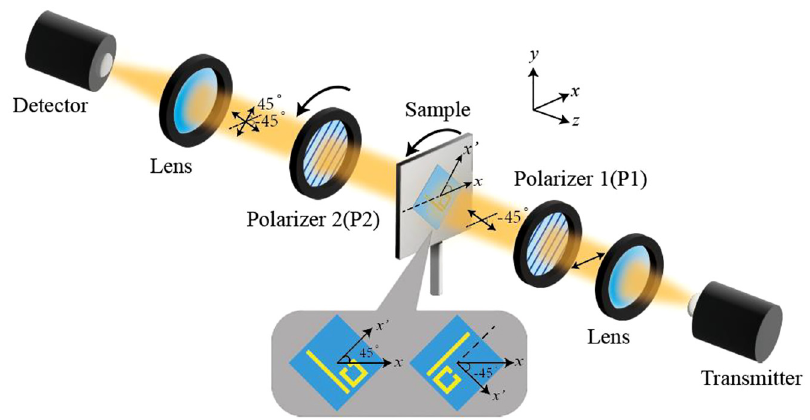
Figure 2: Schematic diagram of the experimental measurement.